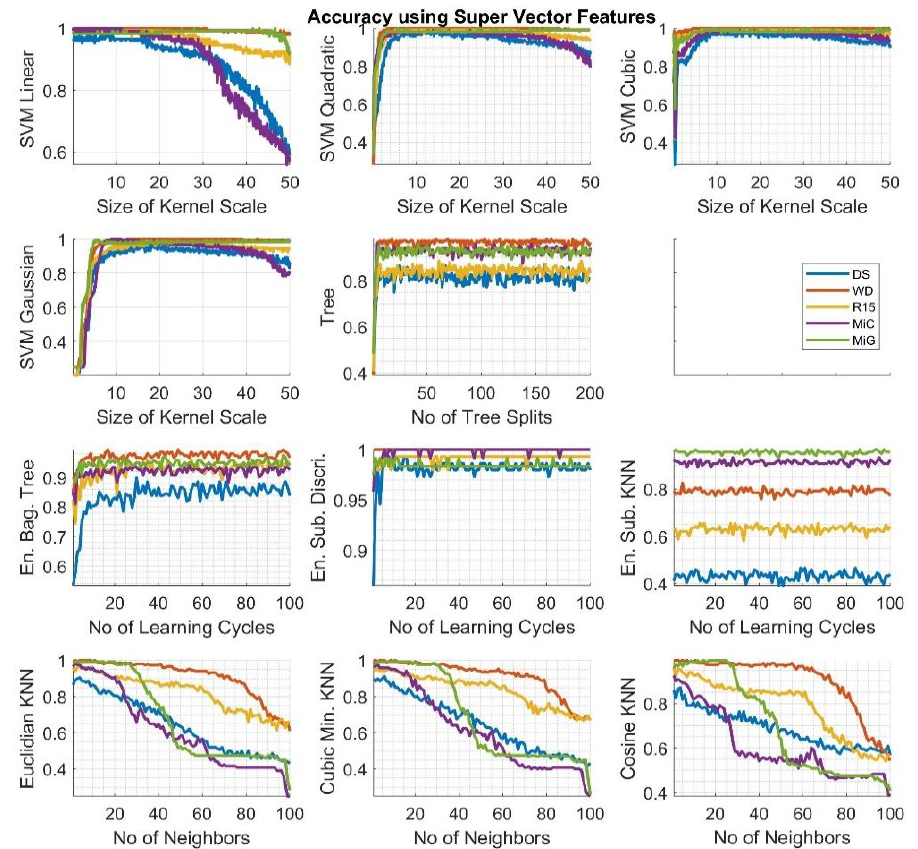
Figure 4. Calculation results—the validation accuracy value for particular algorithms using the Super Vector feature set. The legend for the colors corresponding to the individual sensors can be found on the right side of the image.